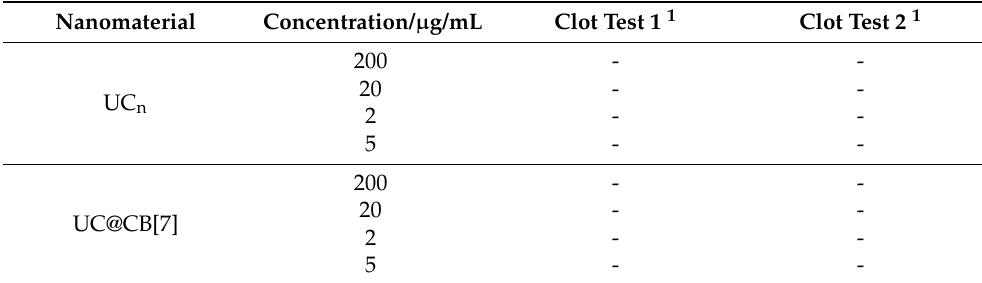
Table 1. Results of the LAL assays at different concentrations of UCNPs in duplicate.